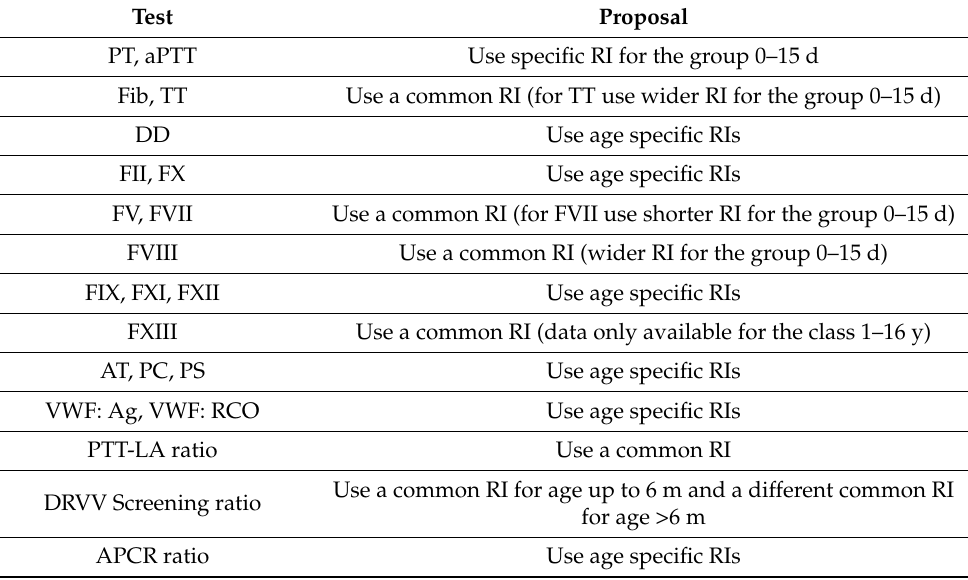
Table 3. Practical proposal to implement age and/or sex specific RIs for coagulations